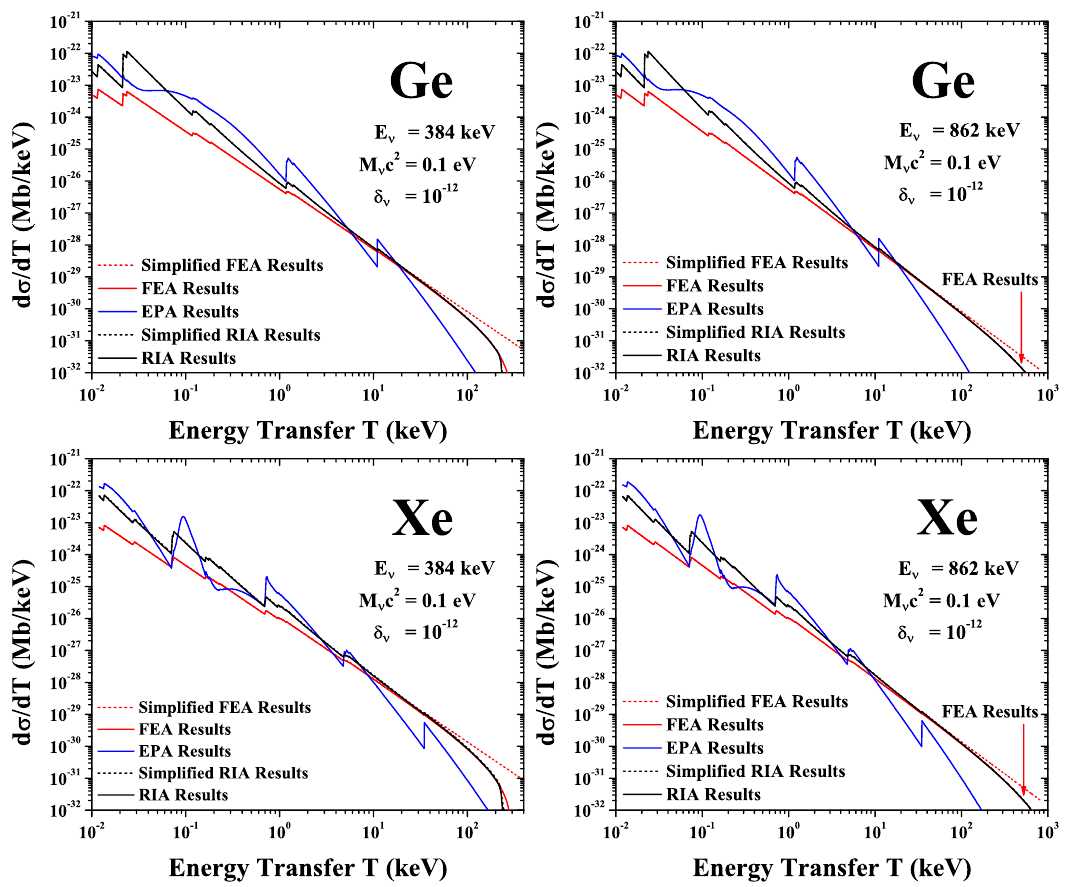
Figure 8 . Differential cross sections of atomic ionization process for Ge and Xe atoms induced by millicharged neutrinos. In this figure, the mass and millicharge of neutrino are chosen as m 0 . 1 eV and δ = 10 − 12 , respectively. The energies of 7 Be solar neutrinos are E ν E ν = 862 KeV. The same as in figure 4 and figure 5, the numerical results from FEA, EPA and RIA approaches are given for comparisons. The red solid lines correspond to the FEA results calculated through eq. (A.3); red dashed lines represent the simplified FEA results calculated through eq. (A.4); blue lines stand for the EPA results calculated from eq. (B.7); black solid lines show the RIA results calculated using eq. (4.22); and black dashed lines present the simplified RIA results calculated using eq.